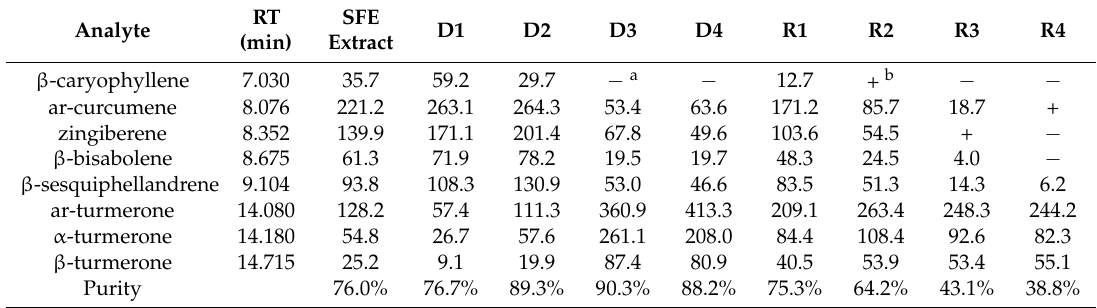
Contents (mg/g) of investigated components in different fractions distilled by molecular